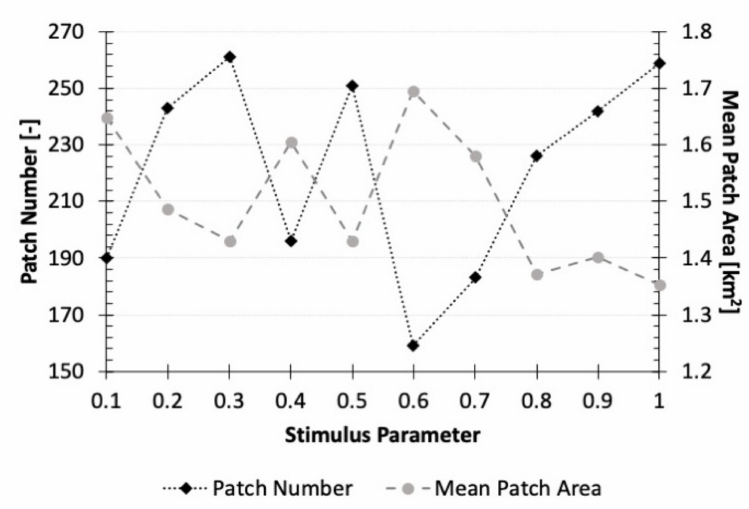
Figure 3. Results of the stimulus parameter sensitivity analysis. Patch number of new urban areas and mean patch area of the newly developed areas resulting from a varying stimulus